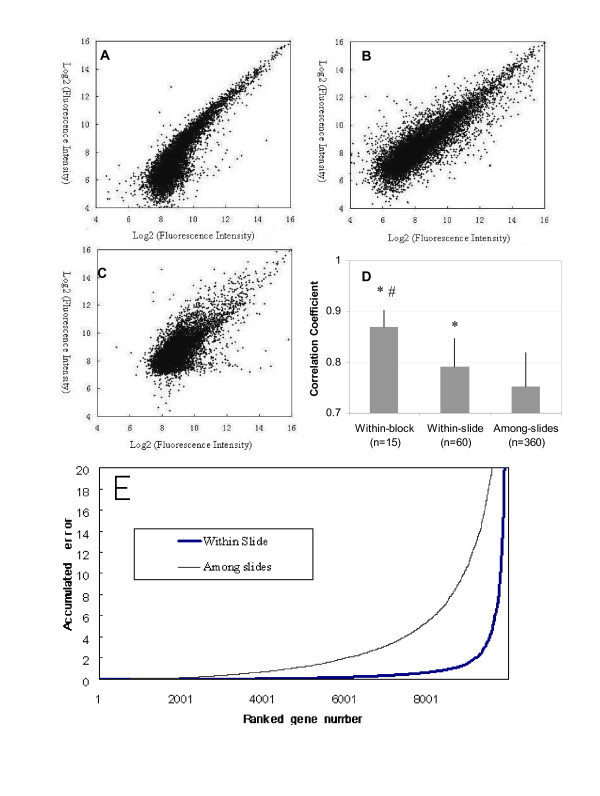
Reproducibility of hybridizations. (A-C):typical scatter plots of self-self hybridization of lung cDNAs between two channels within a block (within-block, panel A), two different blocks in one slide (within-slide, panel B), and among slides (among-slide, panel C), respectively. The cDNAs from an identical lung tissue were labeled with Cy3 or Alexa 647, and hybridized to each block of the slides. The numbers on x- and y-axis were background-subtracted fluorescence intensities of each spot with log2 transformation. (D) A comparison of correlation coefficients from replicated hybridizations. The results were expressed as means ± SE. *P < 0.01 v.s. among-slide; #P < 0.01 v.s. within-slide. (E) Comparison of accumulated errors between within-slide and among-slide groups. For the within-slide group, the log ratios were from parallel hybridization on a single slide. For the among-slides, the log ratios were from different slides. The accumulated errors were calculated as described in Materials and Methods.